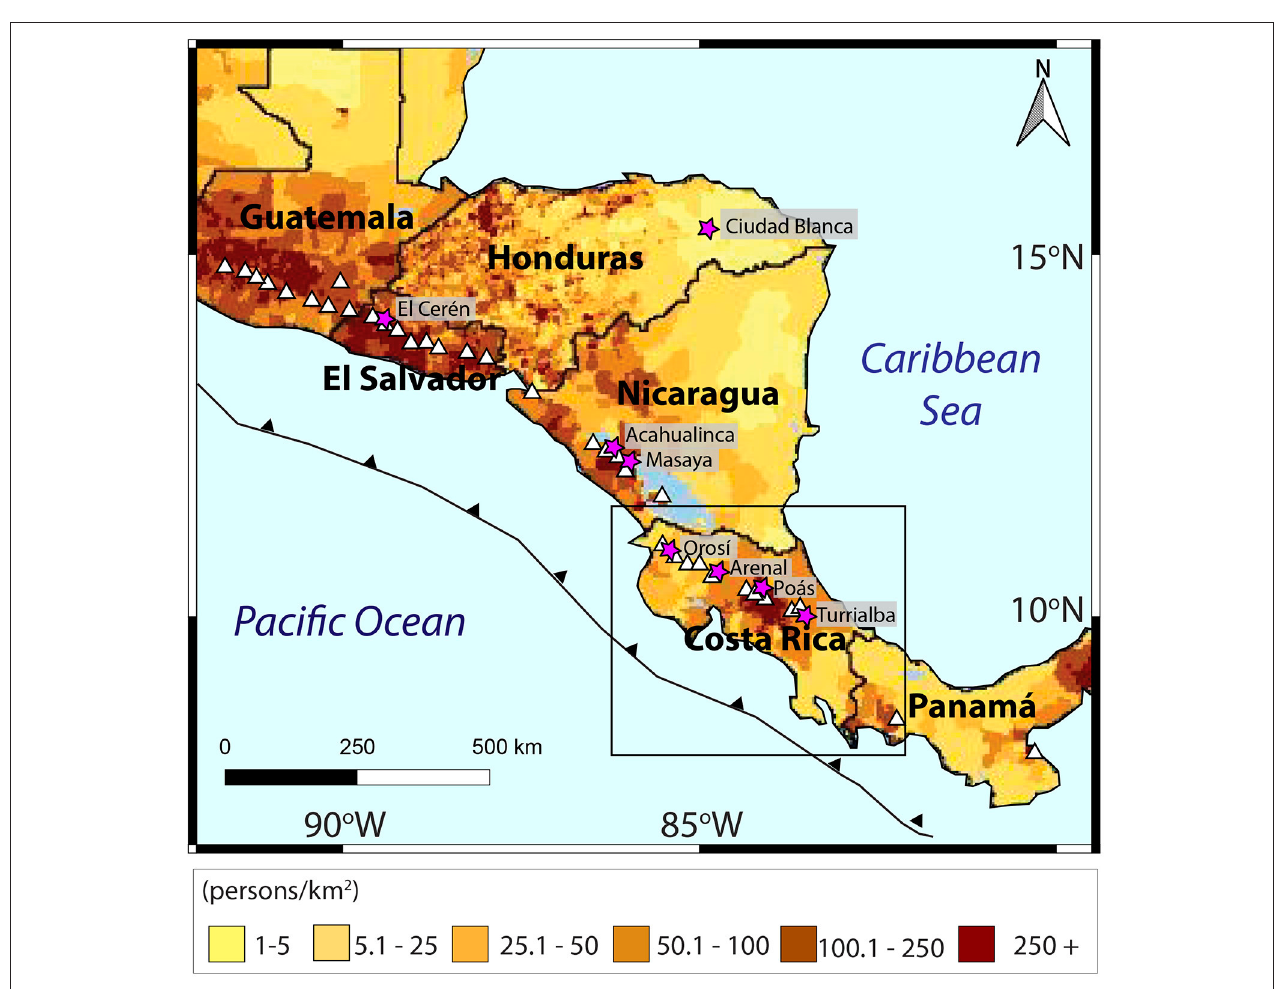
FIGURE 1 | Central America and its population distribution (modified from CIESIN et al., 2011). Volcanoes are identified by white triangles and archeological sites by purple